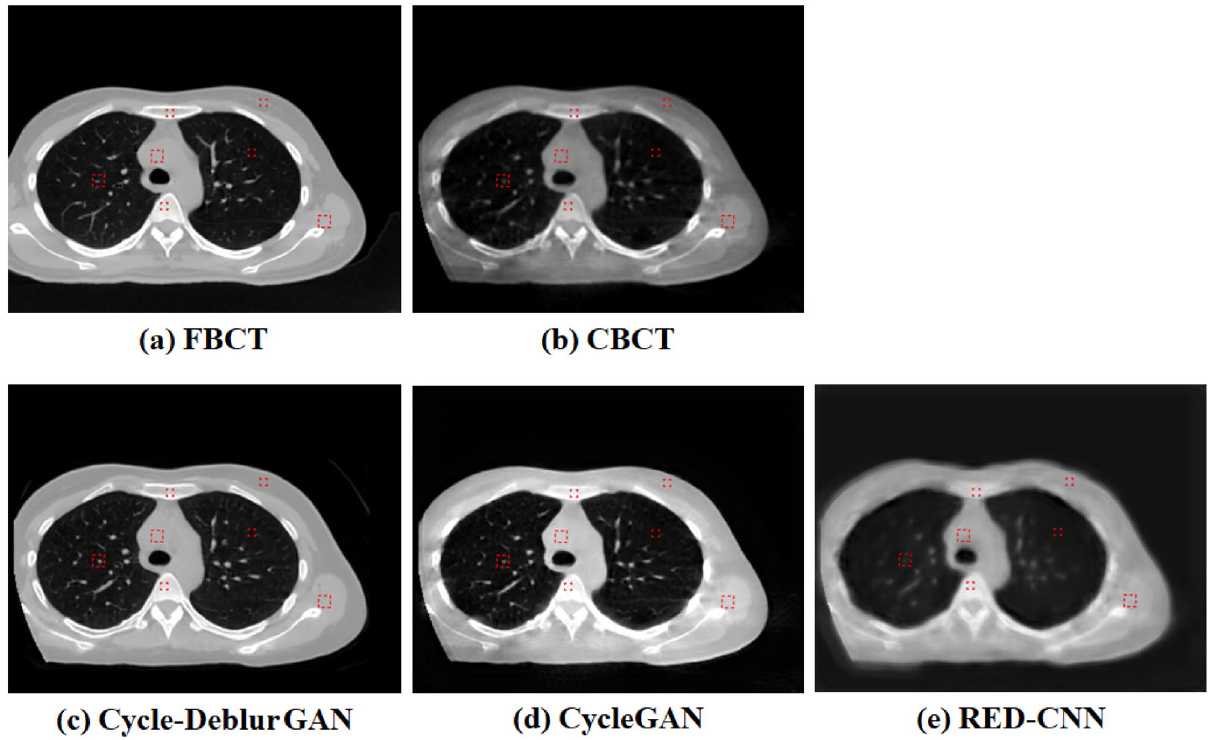
Figure 5. ( a ) FBCT, ( b ) CBCT, and the modeling results of ( c ) Cycle-Deblur GAN, ( d ) CycleGAN, and ( e ) RED-CNN were performed by XVI software and PMOD software. (W = 1450, L = − 225 for all CT